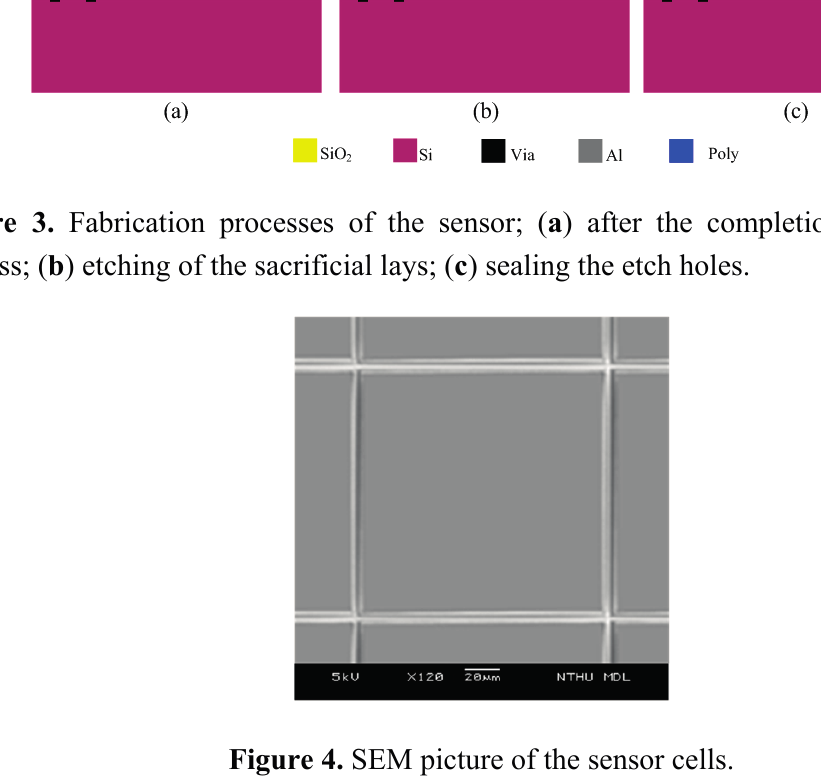
Figure 4. SEM picture of the sensor